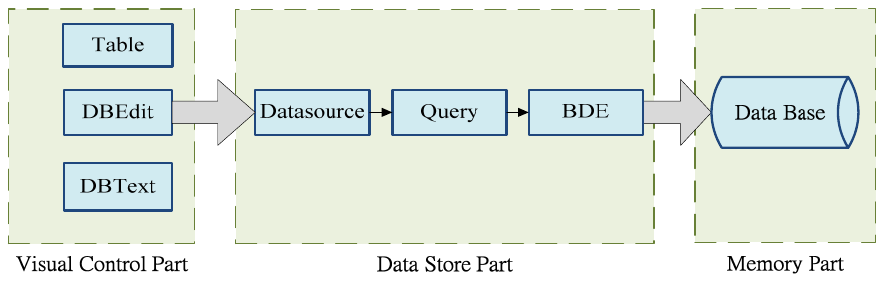
Figure 3. Conceptual diagram of BCB database element connections.